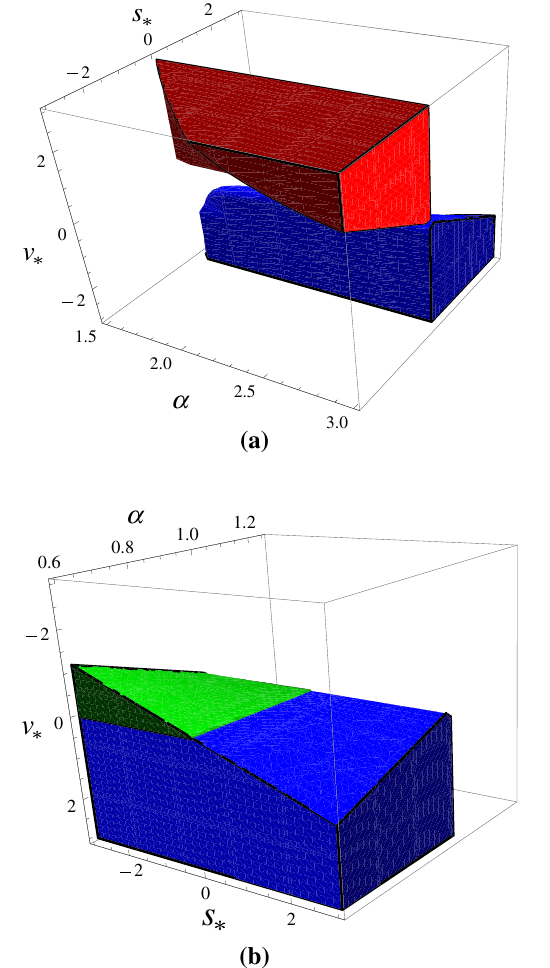
Fig. 5 a Regions of stability of point D 3 : the red shaded region rep- resents the region of stability for dg ( s ∗ ) > 0 and dh (v ∗ ) > 0, the blue shadedregionofstabilityforthecasewhen dg ( s ∗ ) < 0and dh (v ∗ ) < 0. b Regions of instability of point D 4 : the green shaded region represents the region of unstable node for dg ( s ∗ ) > 0 and dh (v ∗ ) > 0, the blue shaded region represents the region of unstable node for the case when dg ( s ∗ ) < 0 and dh (v ∗ ) < 0. In both panels, the remaining unshaded regions represent regions where points are saddle. Here, we have taken w = 0